Question: Express in one sentence what the figure is showing.
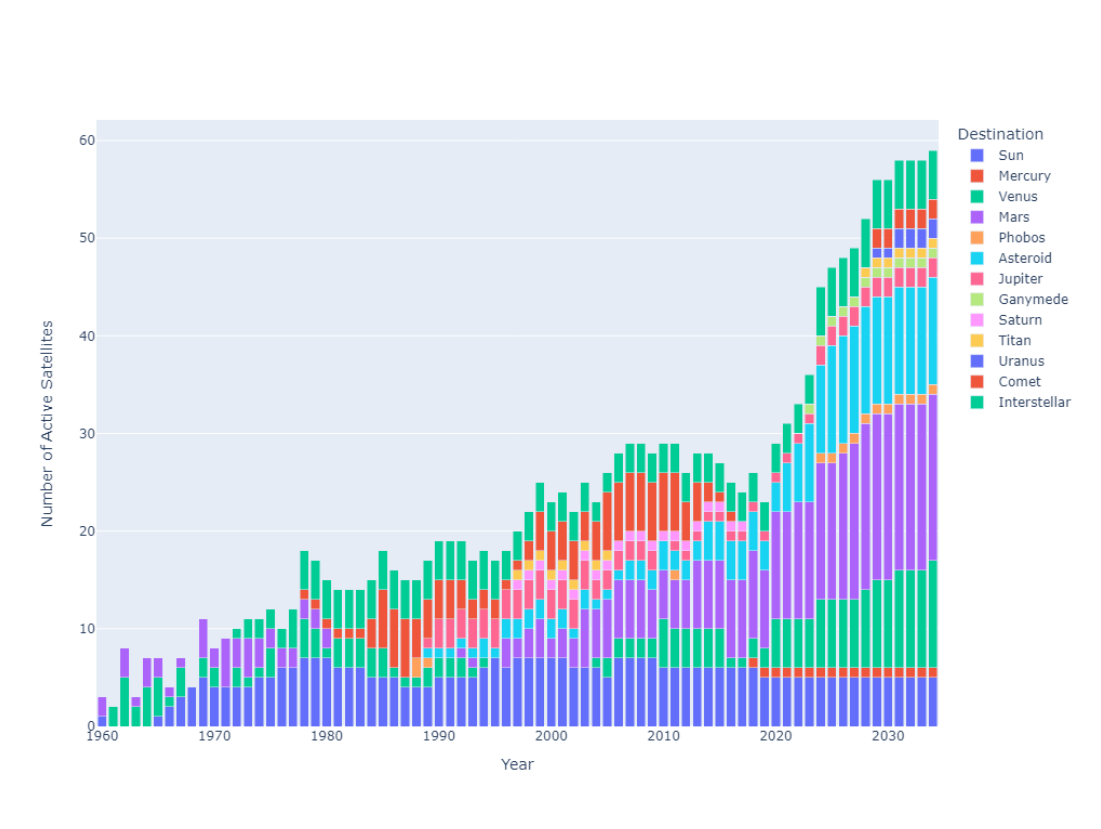
Answer: 1: Active solar system exploration satellites over time, grouped by their furthest destination achieved. Includes confirmed future spacecraft. Adapted from [68] as of January 10th, 2024.